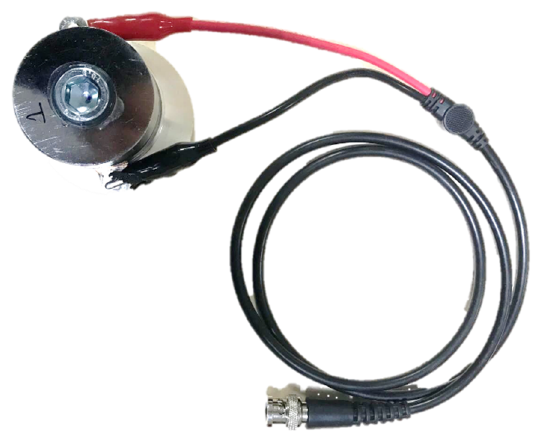
Figure 1. Example of cable connection to High-Power Ultrasonic Transducer (HPUT) using a male BNC test lead cable.